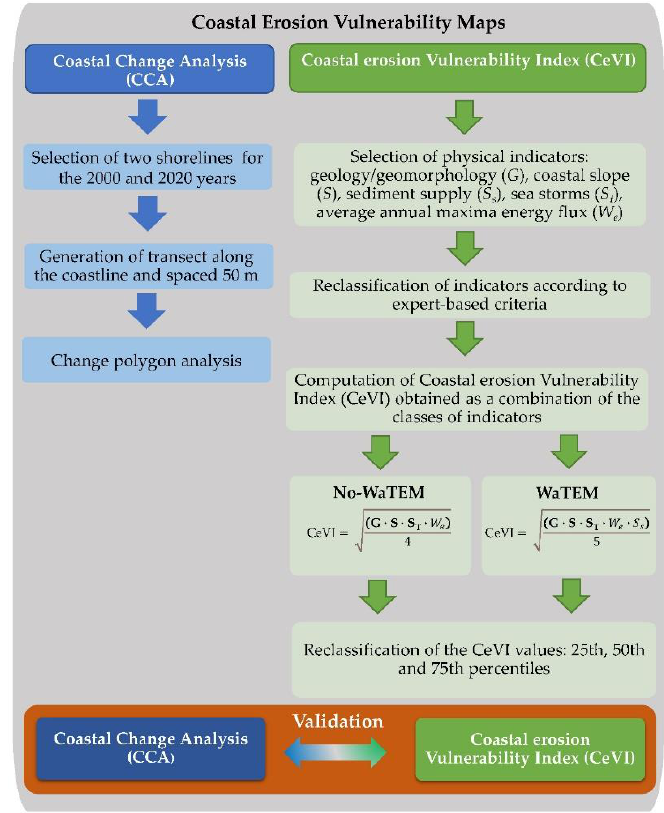
Figure 3. Flow chart related to the new method applied.